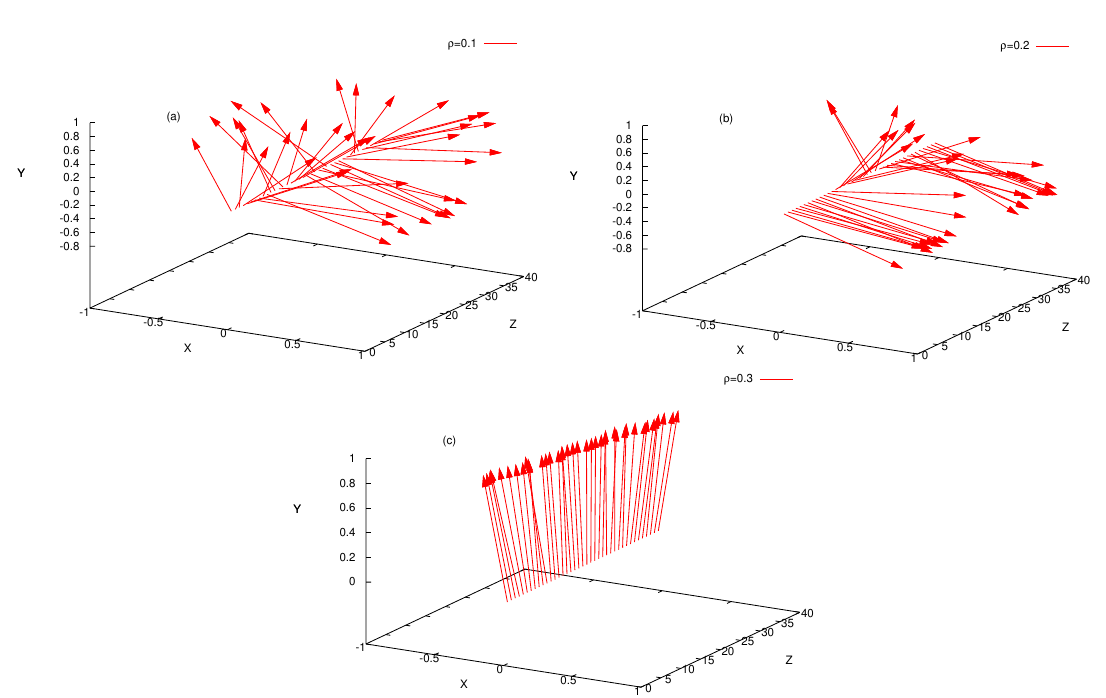
Figure 10. Plot of the layer-resolved director as a function of the z -coordinate across the film for the case N = 32, N = 1500 chains, (cid:101) b = 32, L z = 40, ∆ z = 1.0, and the densities ρ = 0.1 ( a ); ρ = 0.2 ( b ); and ρ = 0.3 ( c ). The arrows show the orientations of the corresponding 40 unit vectors for each value of z . Note the different scales for X -, Y - and Z -directions. Reproduced from [45] with the permission of Wiley-VCH.